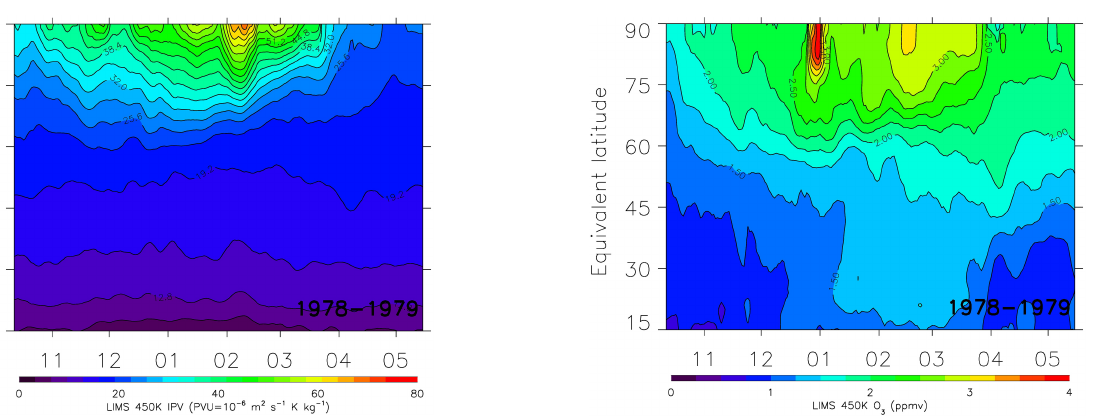
Figure 21. As in Fig. 18, but for ozone at 450K (CI is